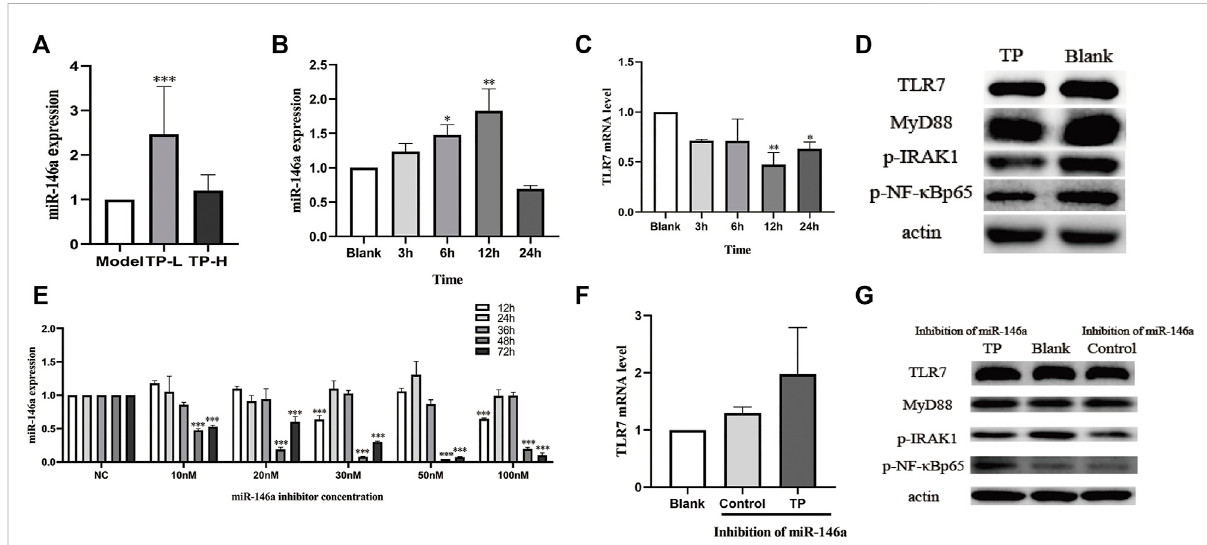
The effects of TP on miR-146a and the TLR7/NF- κ B signaling pathway. (A) The effect of TP on miR-146a expression in the spleen of MRL/lpr mice. (B) The effects of TP on miR-146a expression in Raji cells at different time points. (C) The effect of TP on TLR7 mRNA expression in Raji cells at different time points. (D) The effect of TP on the protein expression of the TLR7/NF- κ B signaling pathway in Raji cells. (E) Inhibitory ef fi ciency of a miR-146ainhibitoronmiR-146ainRajicellsatdifferentconcentrationsandtreatmentdurations. (F) TheeffectofTPonTLR7mRNA expression in Raji cells upon treatment with a miR-146a inhibitor. (G) The effect of TP on the expression of TLR7 signaling pathway proteins in Raji cells treated with a miR-146a inhibitor. (* p < 0.05, ** p < 0.01, *** p < 0.001).